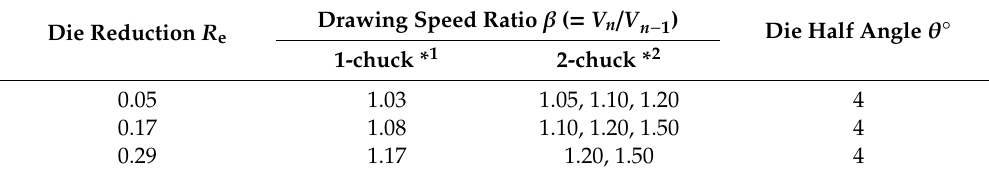
Figure 1. Schematic illustration of the draw-bench machine used in this study. The parameters V n − 1 and V n are the drawing speeds on the die’s entrance and exit sides, respectively. Table 3. Drawing conditions.